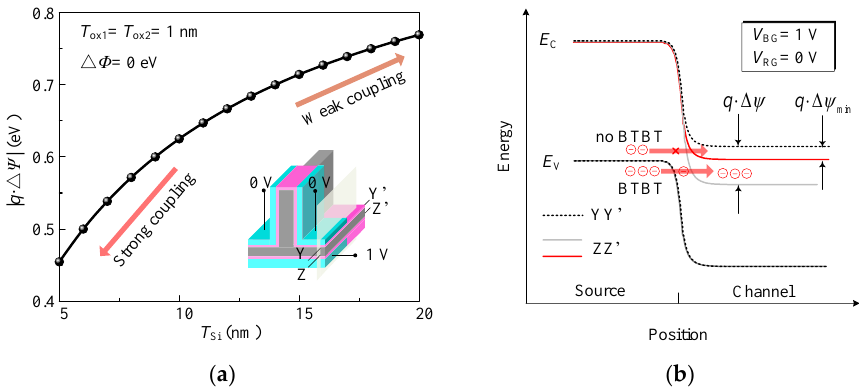
Figure 5. ( a ) The variation of the | q ·Δ ψ | with the various body thickness at input logic of ABC = “001”. ( b ) Energy band distribution along YY’ and ZZ’ cutline.